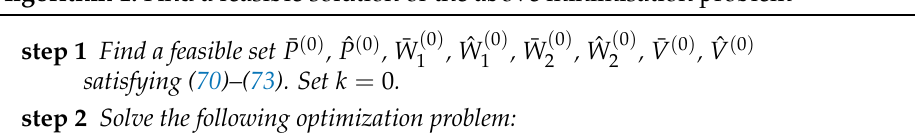
Algorithm 1: Find a feasible solution of the above minimisation